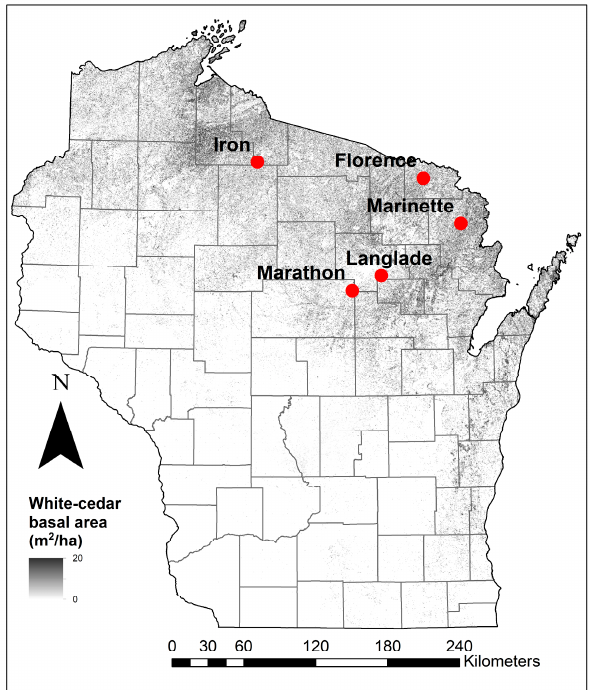
Figure 1. Locations of 2016 Wisconsin white-cedar study sites (red) and basal area of white-cedar across the state [25].